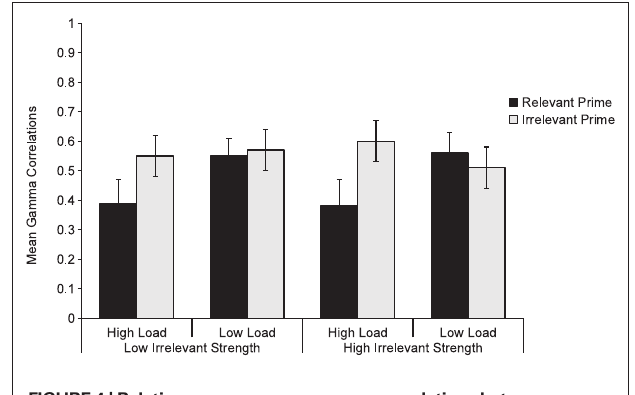
FiGure 4 | relative accuracy: mean gamma correlations between participants’ subjective probability judgments and the corresponding objective probability values for experiment